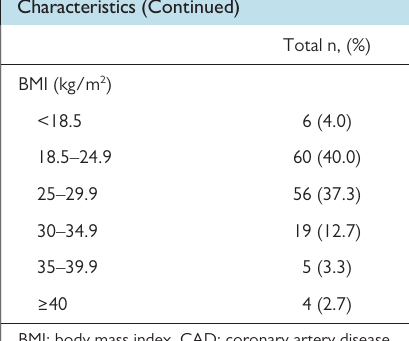
Table 1. Patients ’ Sociodemographic and